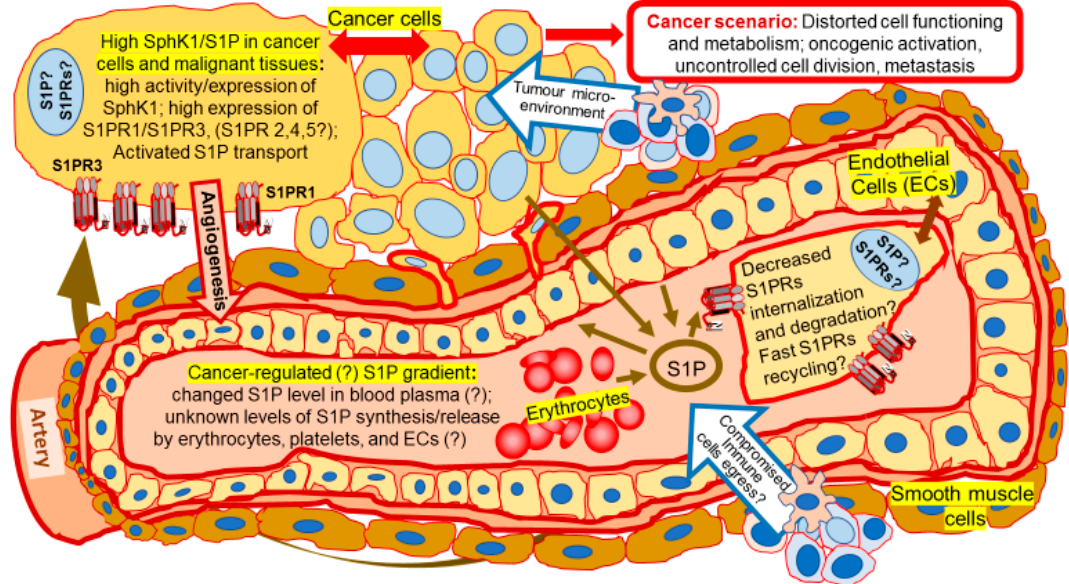
Figure 2. Cancer scenario: Transformation of SphK/S1P/S1PRs signaling. Cancer cells are shown outside of the artery wall. A transverse cut through the artery shows an inside space of the blood vessel filled with blood plasma and blood cells (only erythrocytes are shown), as well as a layer of endothelial cells surrounded by smooth muscle cells. Endothelial cell layer and enlarged single endothelial cell are indicated by a double-ended arrow. Levels of SphK1 expression and activation are high in cancer cells. The regulation of plasma S1P levels and S1P release by blood cells/endothelial cells remain to be confirmed in cancer patients. S1P levels/S1P gradient is hypothetically changed in blood plasma of cancer patients comparing to healthy controls. It is not clear how changed S1P plasma level would influence the level of S1PR expression and signaling. Overactivation and delayed degradation of S1PRs in cancer cells results in reinforced signaling of this pathway and cancer-related pathological consequences including cancer-directed angiogenesis [21–23,70–75], formation of tumor microenvironment [32,76–78], transformed metabolism [68,79], and cancer progression [5,6,11,67,80–83]. Arrows indicate the movement of S1P and direction of its effects. The arrow directed from S1P to the endothelial cell indicates that S1P also activates endothelial cell signaling via S1PRs. Question marks indicate the gaps in our knowledge of SphK/S1P/S1PRs axis.